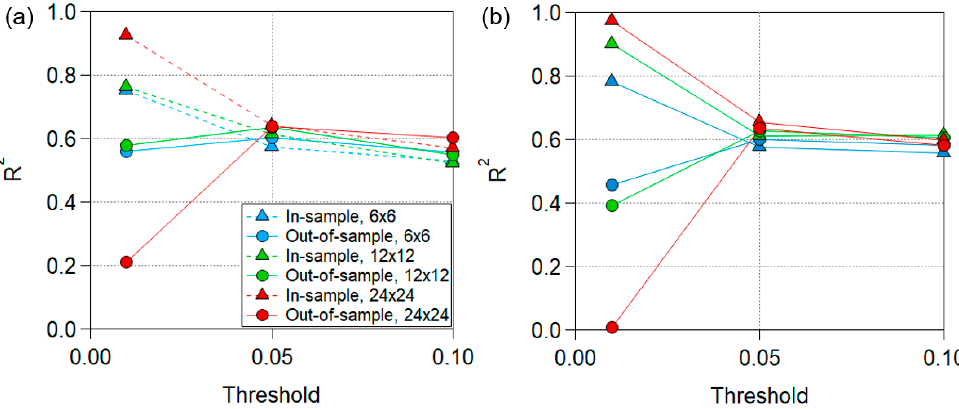
Figure 6. R-squared for nationwide models: ( a ) excluding month factor and ( b ) including month factor. Table 9. R-squared and absolute errors in n σ of nationwide model with/without accurate weather forecasting (Month factor: included, hidden layer layout: 24 × 24, threshold: 0.05).